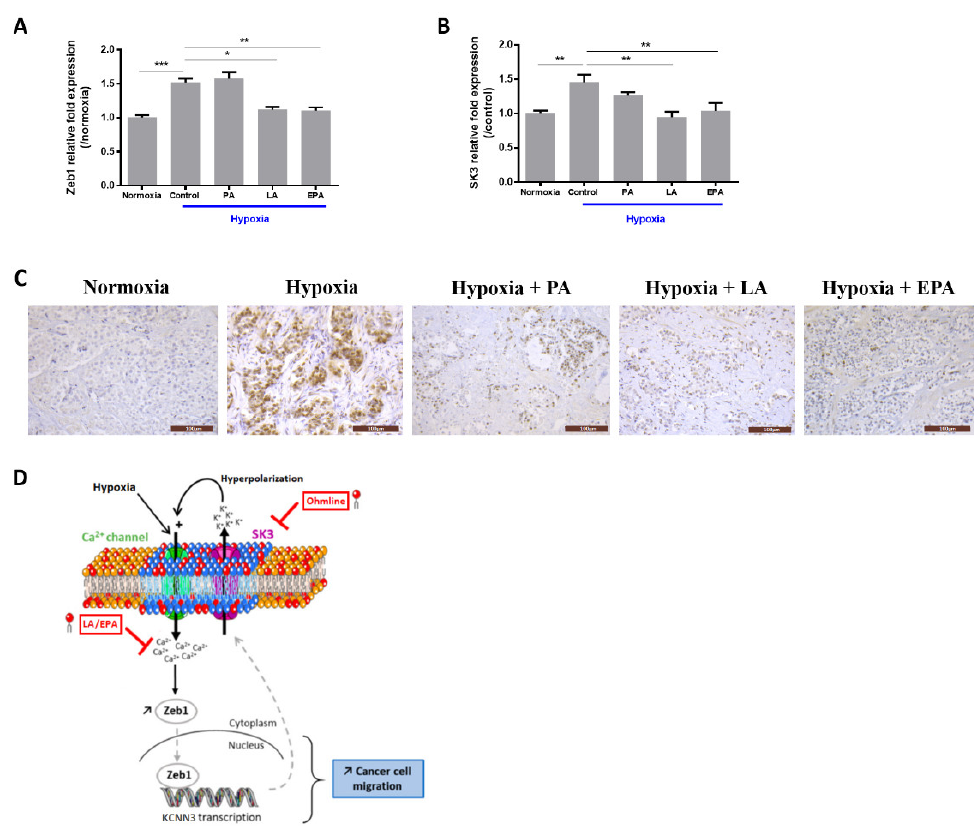
Figure 3. Linoleic acid (LA) and eicosapentaenoic acid (EPA) inhibit hypoxia-induced Zeb1 and